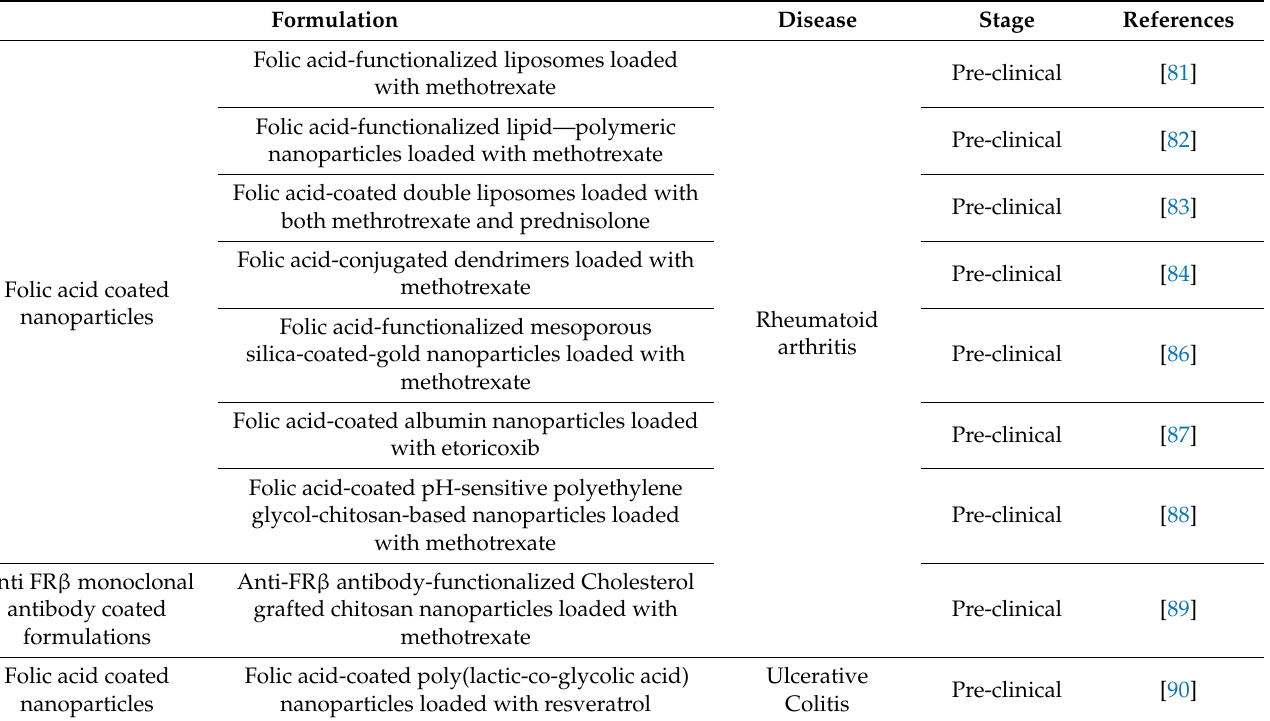
Table 2. FR targeted nanoformulations designed for the treatment of inflammatory